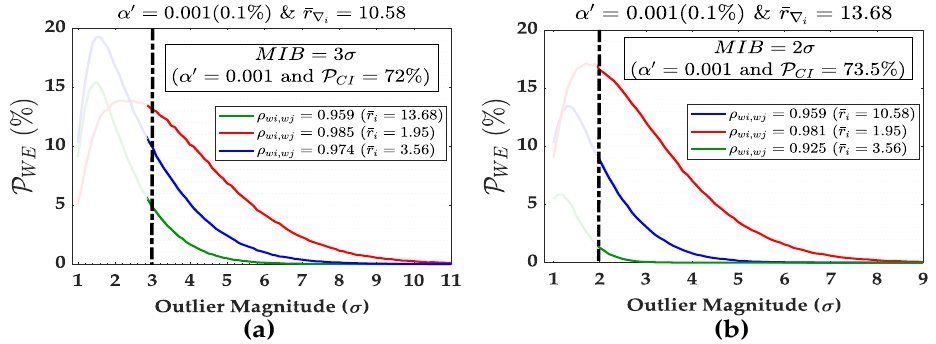
Figure 20. Relationship of the individual contributions to the overall probability of wrong exclusion ( P WE ) with correct identification rate P CI and MIB for α (cid:48) = 0.001. ( a ) Example for measurement ∆ h 1 . ( b ) Example for measurement ∆ h 4 .